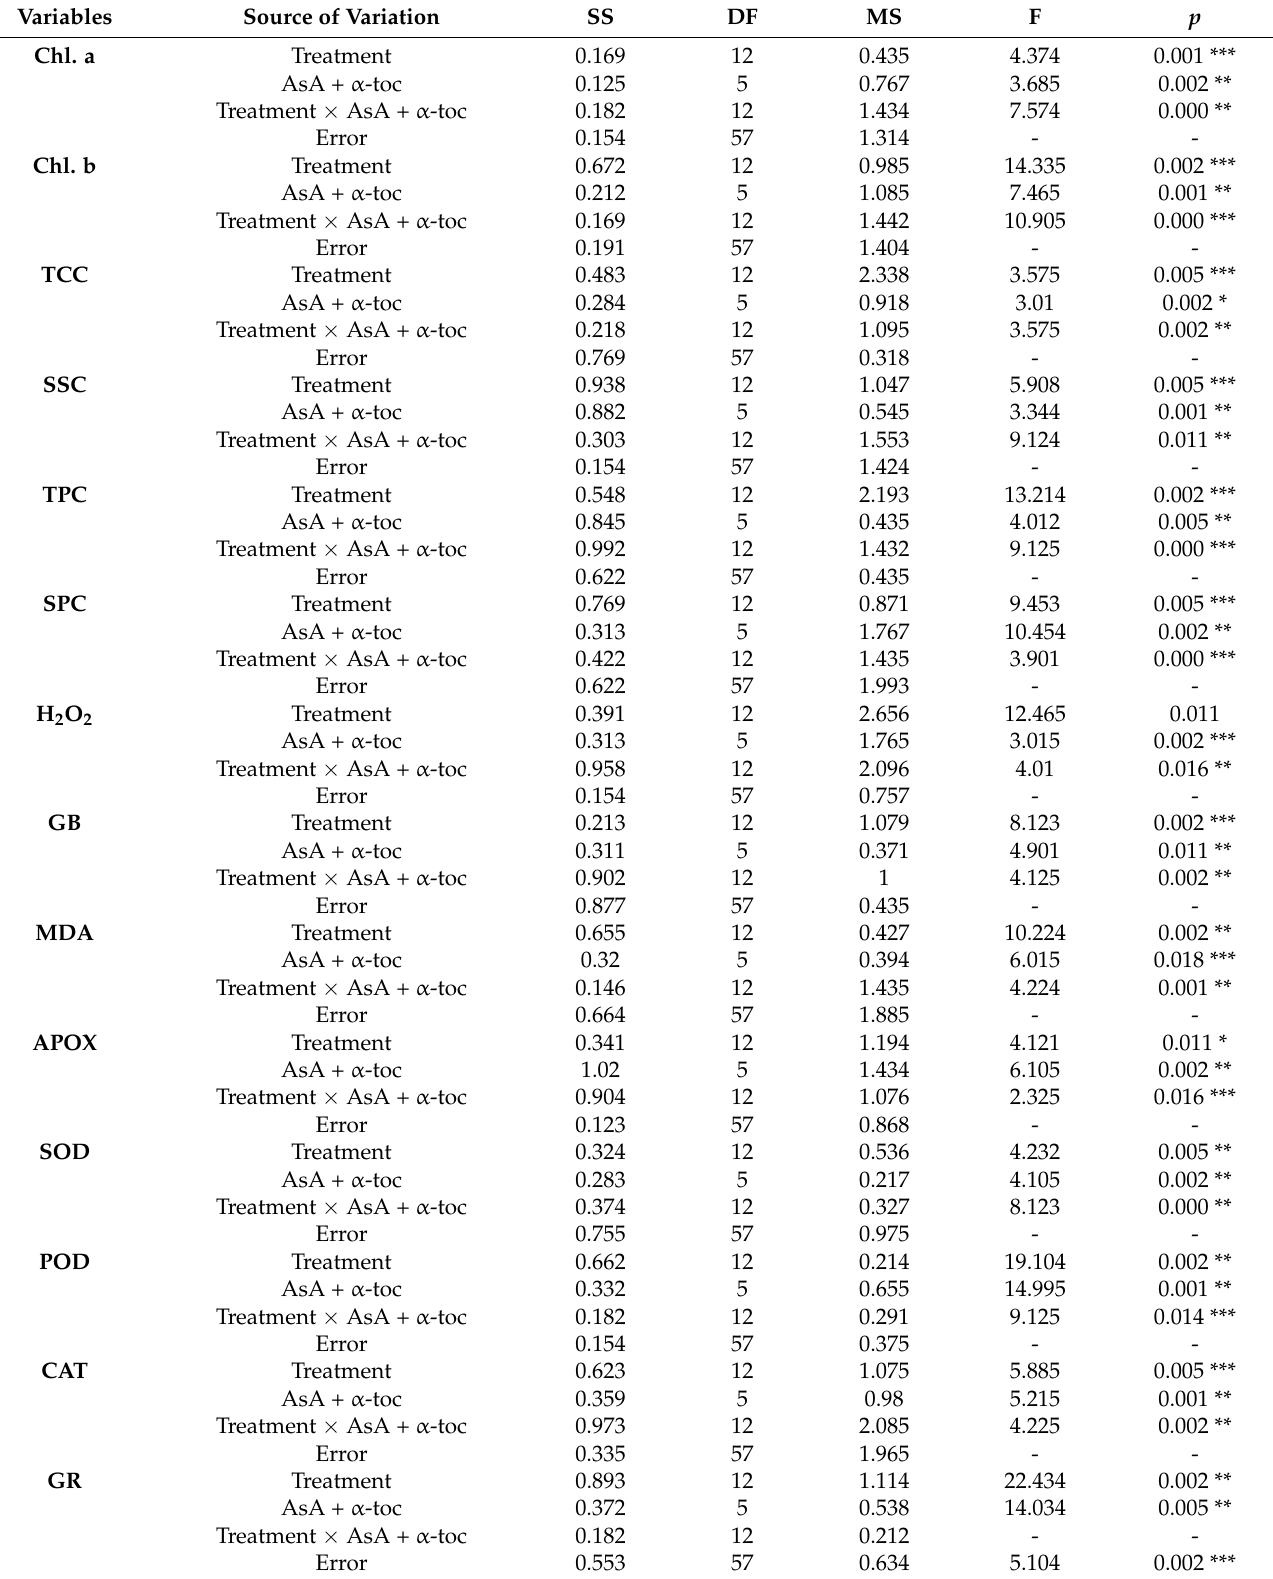
Table 4. Summary of analysis of variance (ANOVA) based on the physiological characteristics of A. sativa grown under drought